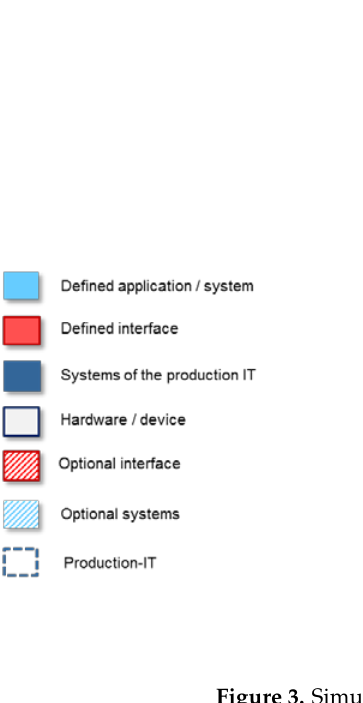
Figure 3. Simulation environment of the software framework.